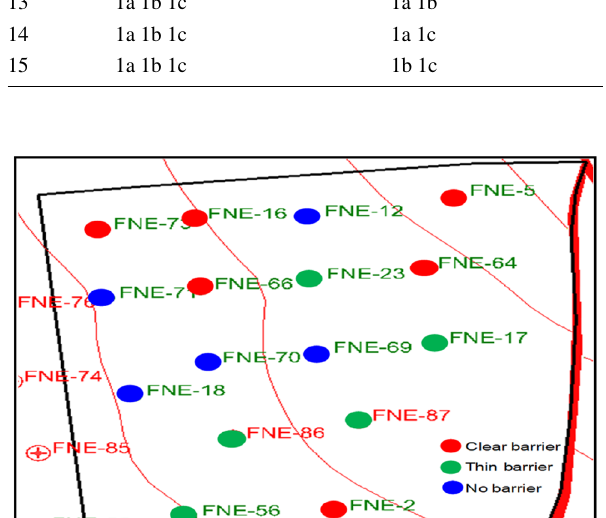
Fig. 11 Well group